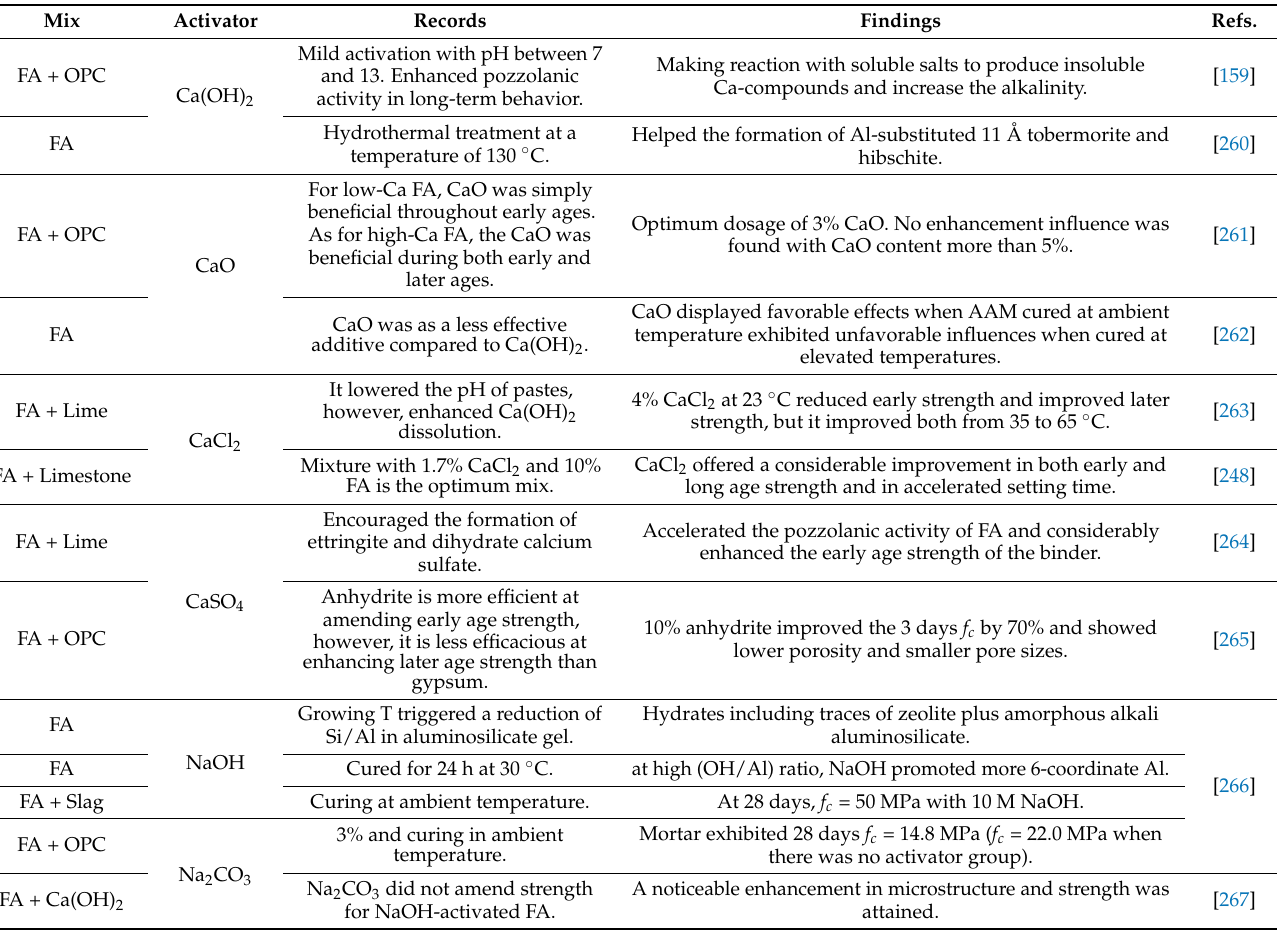
Figure 15. Cumulative heat of hydration after 2-days for cement and different FA-based pastes [140]. Reprinted with permission from Elsevier [140]. Table 12. Summary of Ca-based and Na/K-based activators in FA